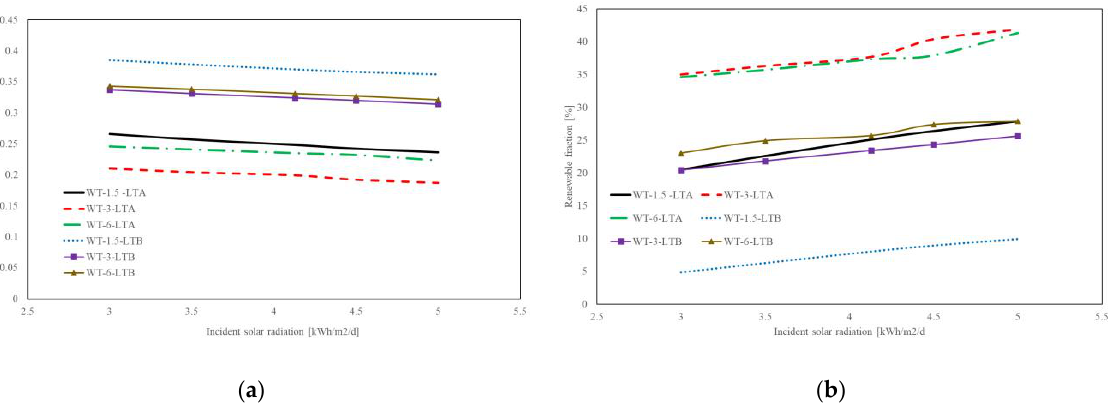
Figure 9. Solar potential parametric study for the default wind pattern for different wind turbines. ( a ) COE vs. solar potential; ( b ) Ren.Fr. vs. solar potential.